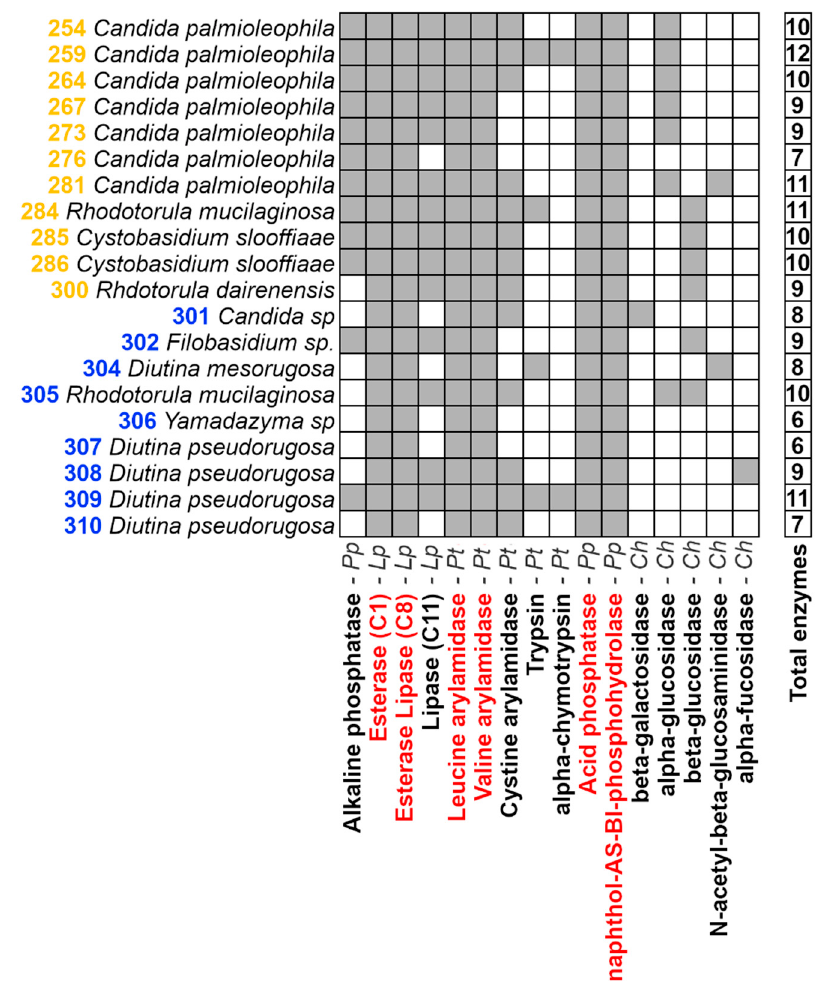
Figure 2. Hydrolytic enzymes detected (gray filled squares) in yeast isolates using API ® ZYM Bio- mérieux. Isolates in yellow were recovered from S. violacea and those in blue from G. chilensis . The enzymes shared by all the samples are shown in red. Pp: Phosphatase, Lp: Lipase, Pt: Protease, and Ch: glycosidases.